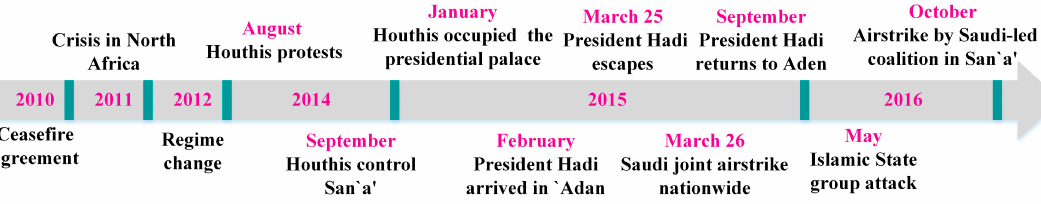
Figure 2. A timeline of the Yemen crisis.